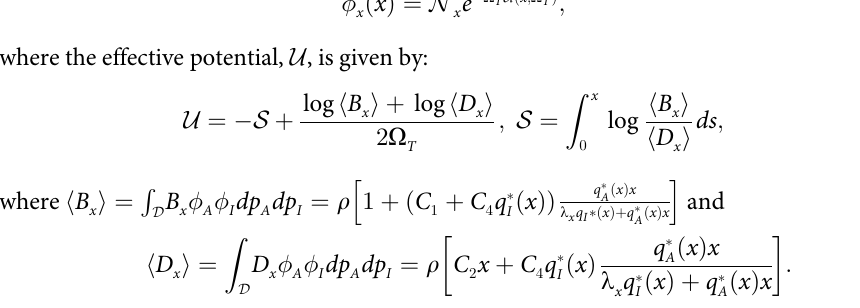
ffiffiffiffiffiffiffiffiffiffiffiffiffiffiffiffiffiffiffiffiffiffiffiffiffiffiffiffiffiffiffiffiffi ð p B J